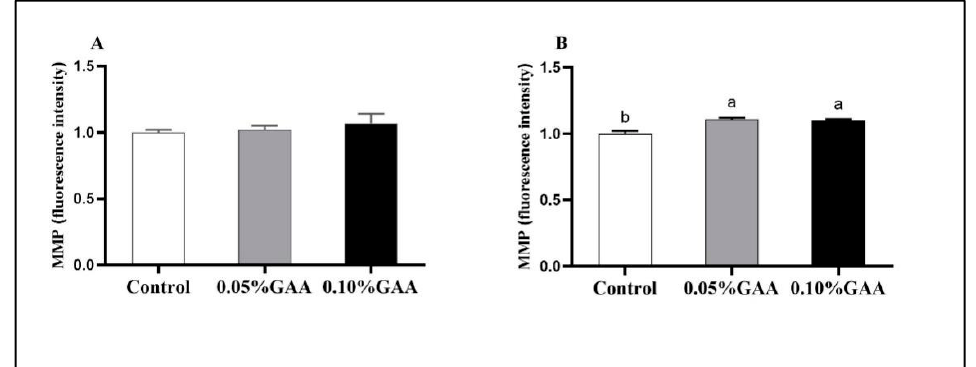
Figure 4. Effects of guanidinoacetic acid supplementation on the mitochondrial membrane potential (MMP) of ( A ) longissimus thoracis muscle and ( B ) semitendinosus muscle in finishing pigs. Means with different letters differ significantly ( p < 0.05). Values are presented as the mean ± SEM ( n = 5). Control: Finishing pigs were fed a basal diet; 0.05% GAA or 0.10% GAA: Finishing pigs were fed a basal diet supplemented with GAA at 500 or GAA at 1000 mg kg − 1